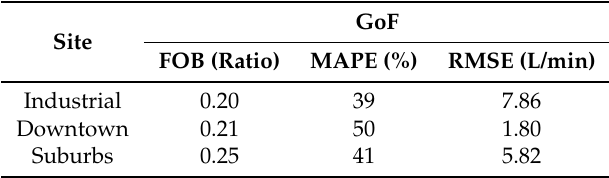
Table 3. The 75% quantile for the Goodness of Fit (GoF) parameters at the three sites over the entire period. FOB, Fraction Out of Bounds.